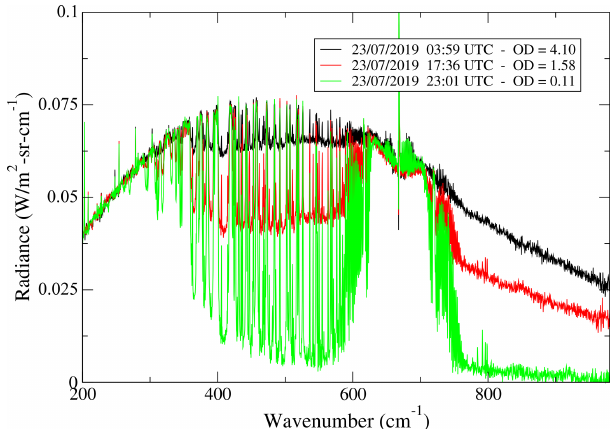
Figure 12. Variability of the cloudy spectra detected by REFIR- PAD during the day of 23 July